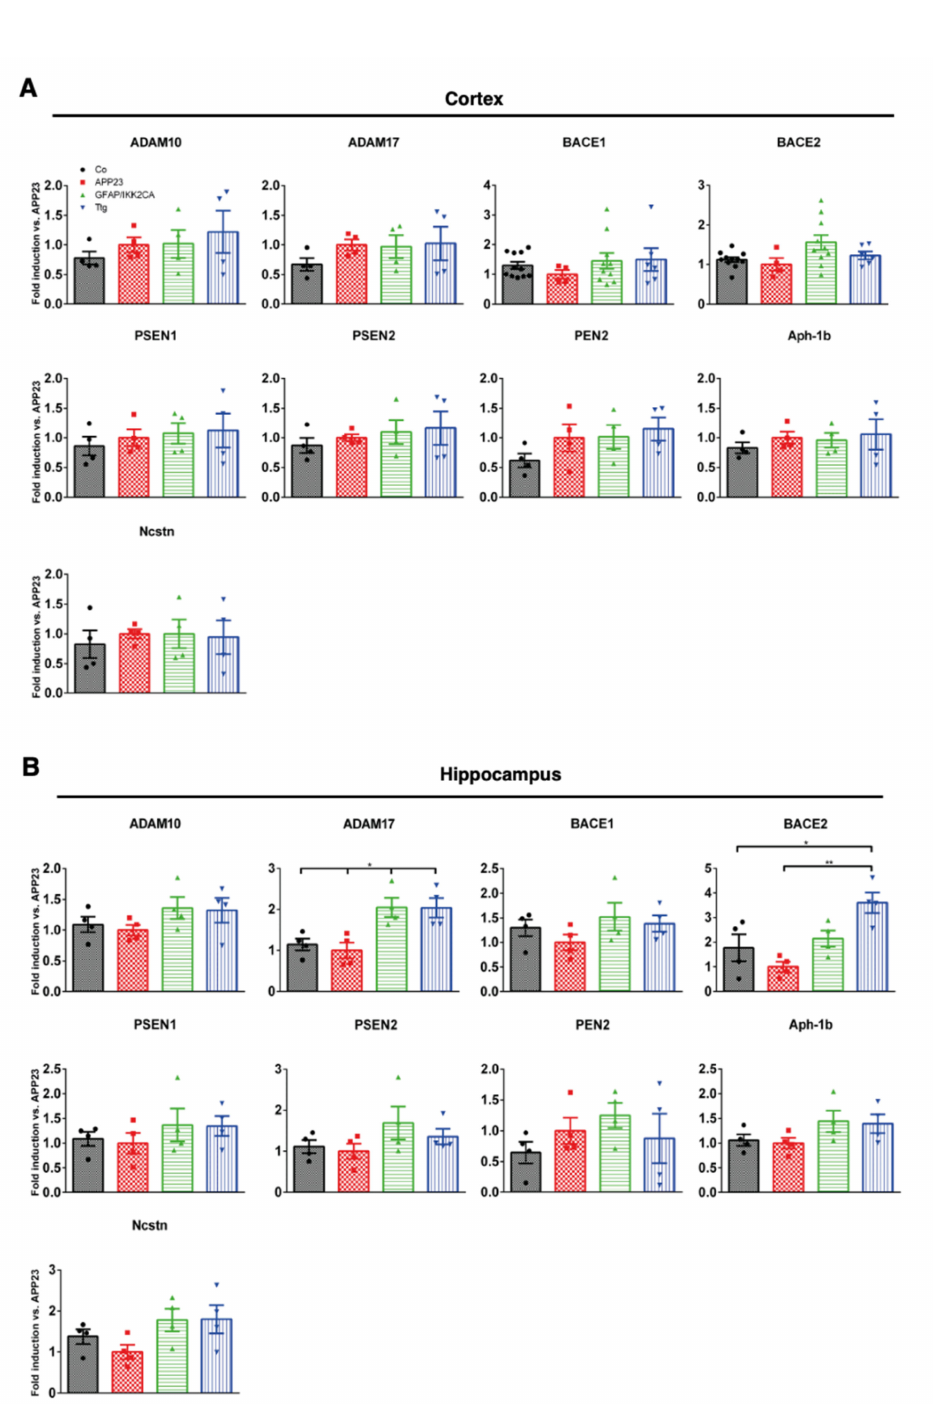
Figure 5. Gene expression of enzymes involved in the processing of APP is selectively affected in the hippocampus of Ttg mice. qRT-PCR analysis of ADAM10, ADAM17, BACE1, BACE2, PSEN1, PSEN2, PEN2, Aph1b, and Ncstn mRNA levels in the cortex ( A ) and hippocampus ( B ) of Co, APP23, GFAP/IKK2-CA, and Ttg mice. In contrast to the cortical region, quantitative analysis shows a signif- icant increase in ADAM17 and BACE2 gene expression in the hippocampal region of GFAP/IKK2CA and Ttg mice compared to Co and APP23 littermates. Expression is normalized to APP23. Statistical analysis: ANOVA multiple comparison test (* p = 0.05; ** p = 0.01). ADAM10 = ADAM Metallopep- tidase Domain 10; ADAM17 = ADAM Metallopeptidase Domain 17; BACE1 = Beta-Secretase 1; BACE2 = Beta-Secretase 2; PSEN1 = Presenilin 1; PSEN2 = Presenilin 2; PEN2 = Gamma-Secretase Subunit PEN-2; APH1B = aph-1 homolog B, gamma-secretase subunit; Ncstn =